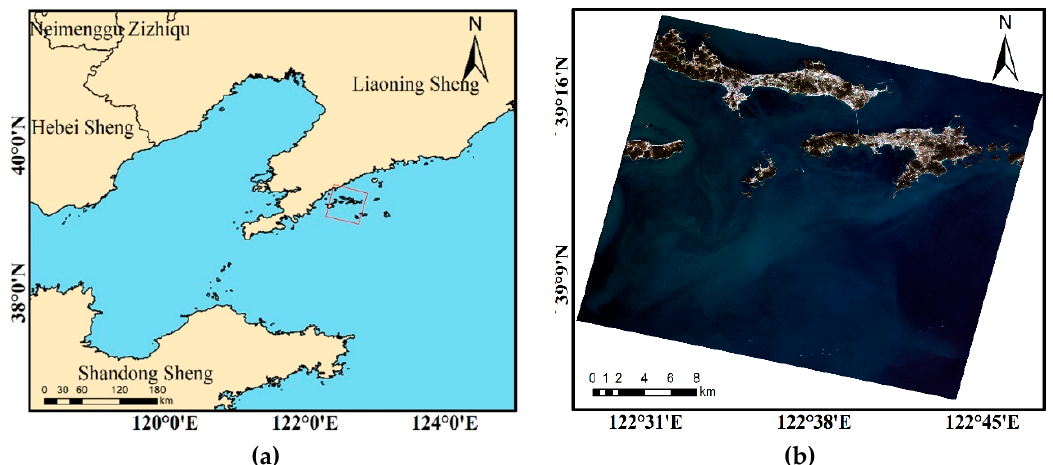
Figure 1. Study area and GF-2 image. ( a ) Study area. ( b ) GF-2 image.